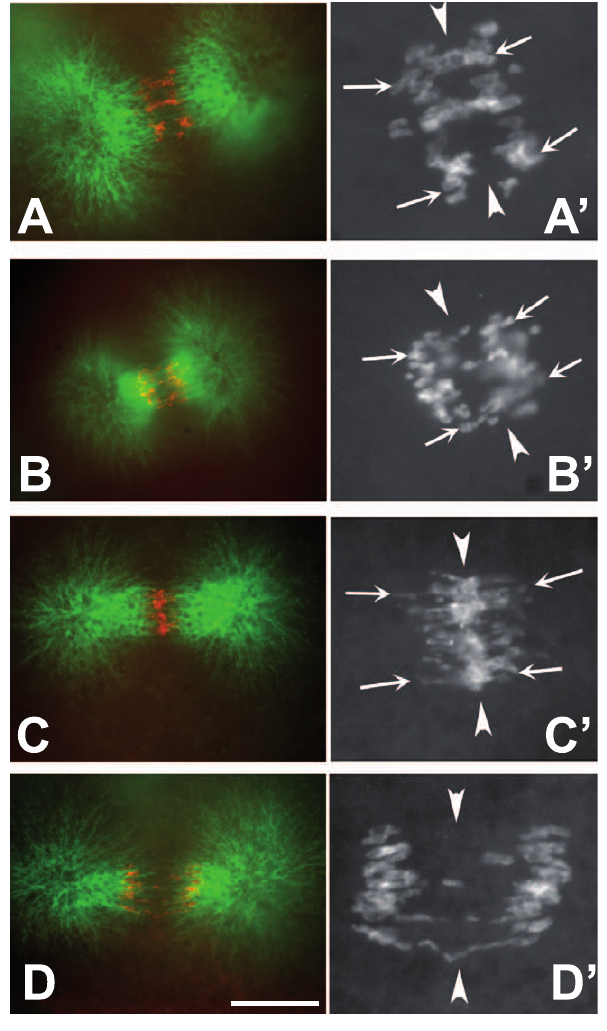
Figure 2. Chromosome segregation failure in the presence of MMS and caffeine. 4-cell stage embryos were incubated for one hour in FSW containing various drugs, fixed, and stained for PH3 (red) and b - tubulin (green). Anaphase figures are shown. Arrowheads indicate the metaphase plate and arrows indicate the leading edge of segregating chromosomes. (A, B) Control (A) and 0.1% MMS-treated (B) embryos show successful chromosome separation with little or no chromosome material remaining at the metaphase plate. PH3 signal is shown magnified in A’ and B’ respectively. (C, C’) The presence of 5 mM caffeine in addition to MMS led to chromosome segregation failure. C’ shows the PH3 signal after magnification. The extent of chromosome separation is similar to that in A’ (compare leading edged), but most of the PH3 signal remains at the metaphase plate (arrowheads). (D, D’) 5 mM caffeine alone allows successful chromosome separation. This figure is in later stage of anaphase then the preceding ones. Scale bar =10 m M in A-D, 4 m M in A’-D’.